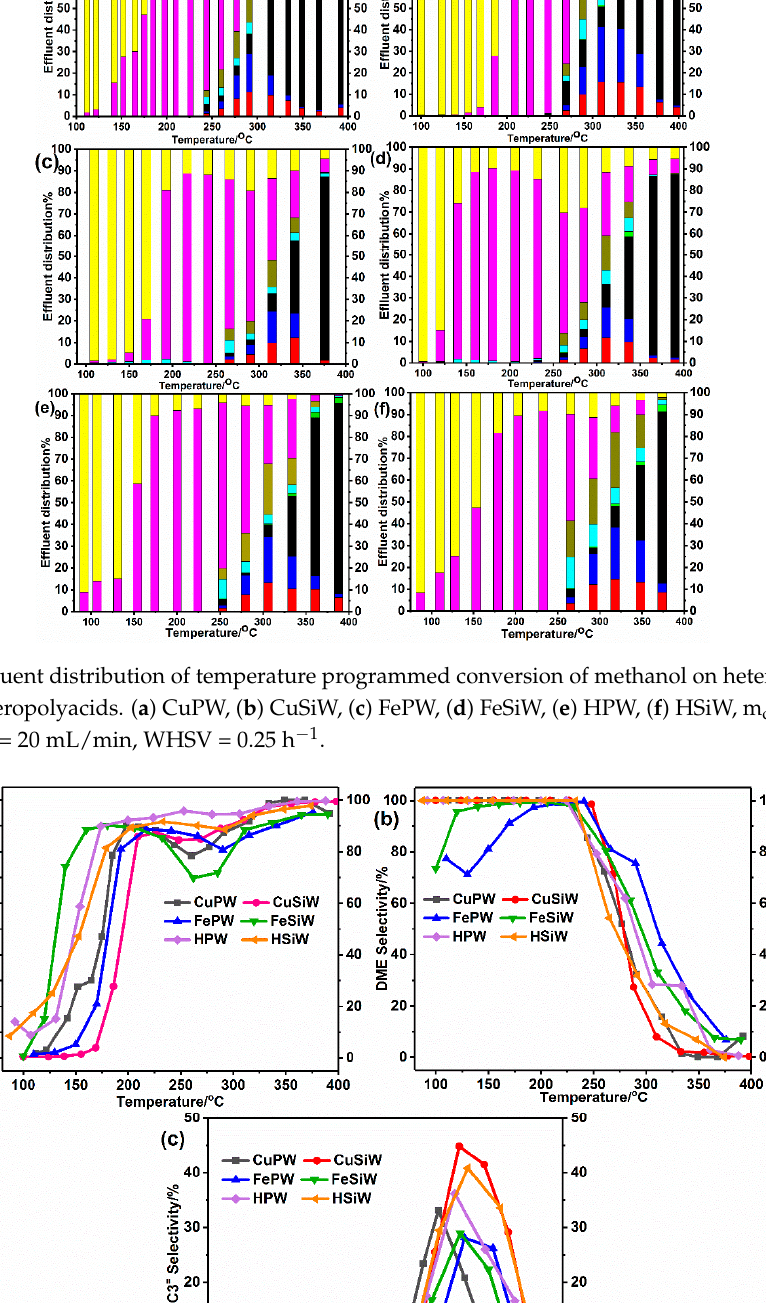
Figure 6. (a) Methanol conversion, (b) DME selectivity and (c) light olefins selectivity of temperature programmed conversion of methanol on heteropolyacid salts and heteropolyacids. m cat = 3.00 g, N 2 flow rate = 30 mL/ min, WHSV = 0.25 h -1 .